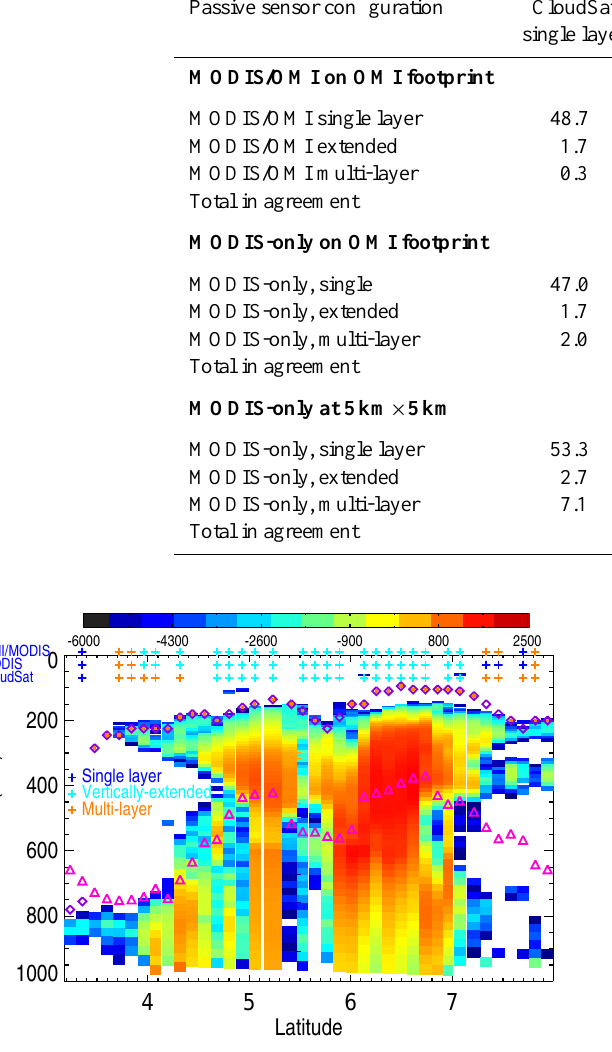
Fig. 8. Similar to Fig. 7 but averaged along-track over the MODIS 5km resolution. Cloud-top pressures are those from the closest MODIS (5km) 2